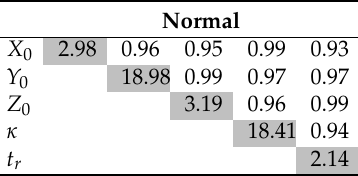
Table 6. Interpreted variance matrix Q ˆ computed from pseudorange observations of 3 satellites and P ˆ P image observations of 1 feature with extended integration model, units are [m, m, m, degree,